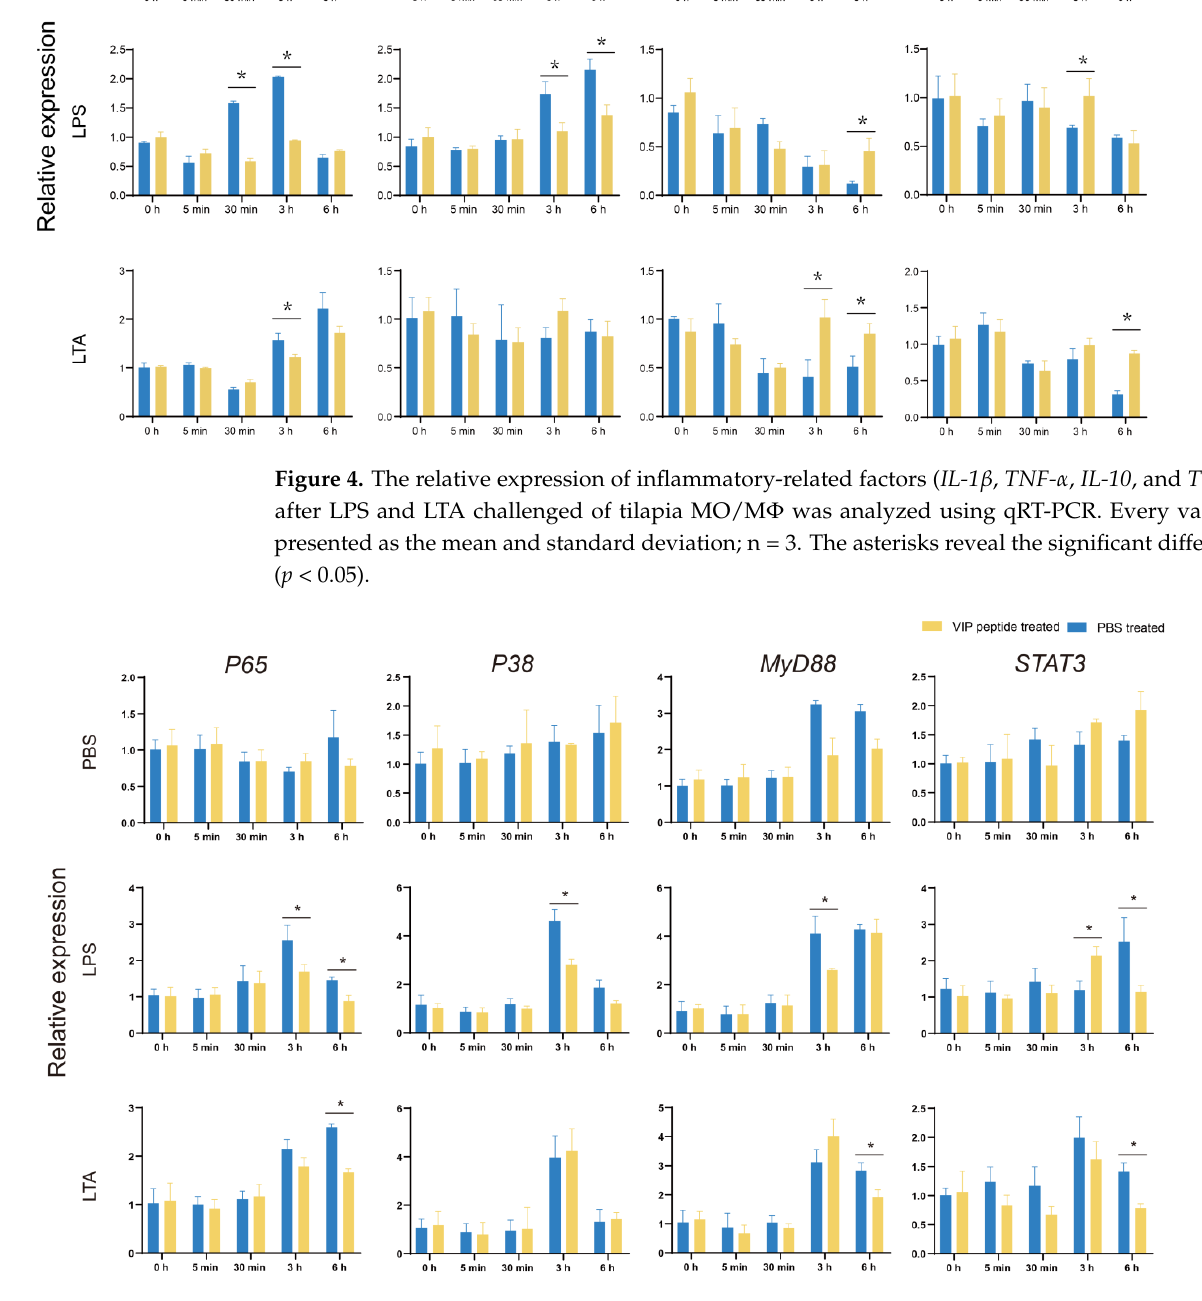
Figure 5. The relative expression of immune-related pathways ( P65 , P38 , MYD88 , and STAT3 ) af- ter LPS and LTA challenges of tilapia MO/MΦ was assessed using qRT-PCR. Every value is presented as the mean and standard deviation; n = 3. The asterisks reveal the significant difference ( p < 0.05).